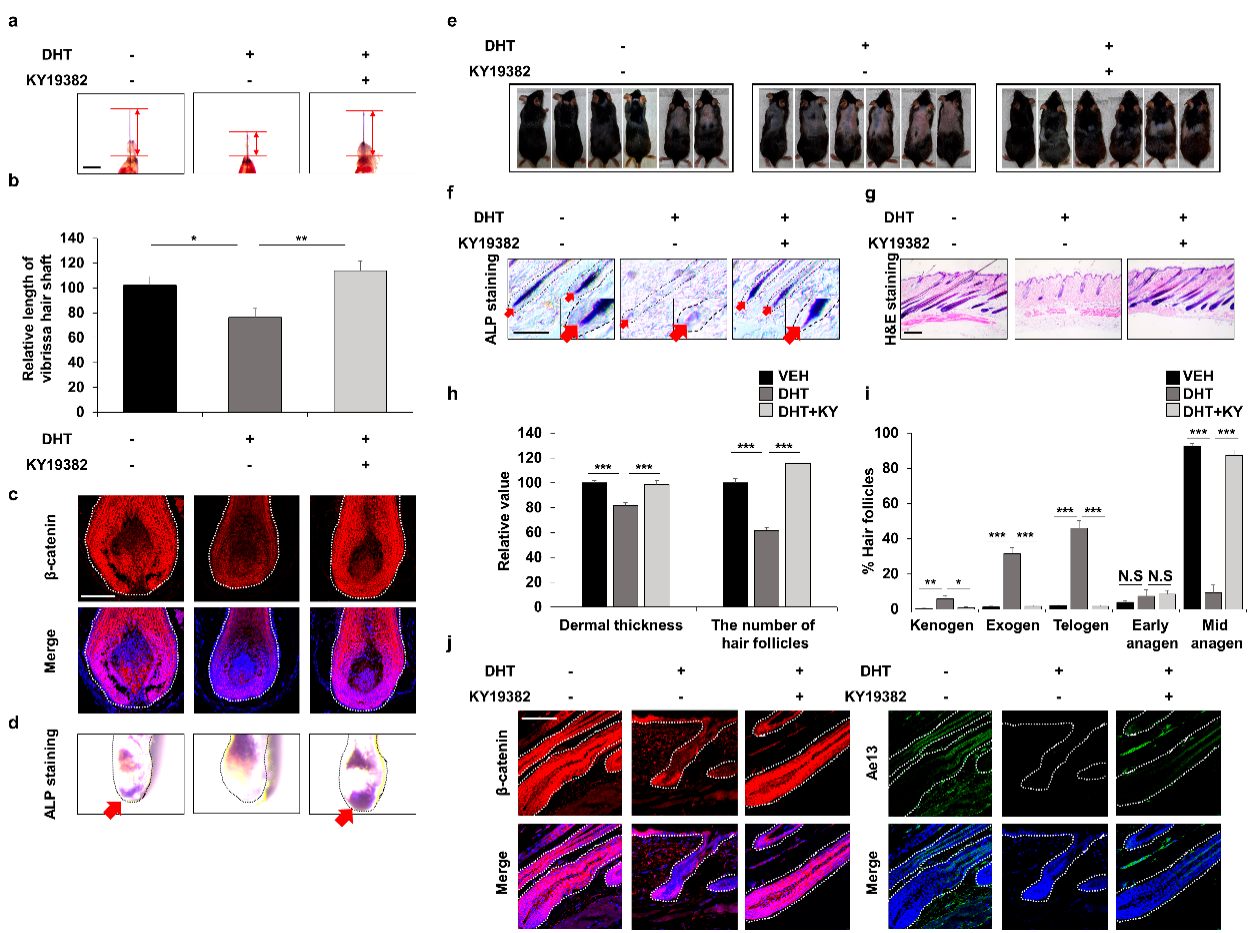
Figure 5. Effects of inhibition of both Cxxc5 and Gsk-3 β functions on hair growth of the DHT-treated mice. ( a – d ) Vibrissa follicles were separated and cultured with 100 nM DHT or 0.5 μ M KY19382 for 4 or 7 days. ( a , b ) The relative length of vibrissa follicles at 7 days ( n = 34). ( c ) IHC staining for β -catenin at 4 days. ( d ) ALP staining for vibrissa follicles. Arrows indicate ALP-positive region. ( e – j ) The dorsal skins of C57BL/6N 8-week-old wild-type mice were shaved and topically treated daily with 100 μ M DHT or 2 mM KY19382. The dorsal skins were harvested at 42 days. ( e ) Gross images of regrown hair in mice ( n = 6). ( f ) ALP staining for dorsal skins. ( g ) H&E staining for mouse dorsal tissues. ( h , i ) Quantitative measurements of dermal thickness, the number of hair follicles, and hair cycle score using H&E images ( n = 30). ( j ) IHC analyses for β -catenin and Ae13 using dorsal skins. Scale bars = 100 μ m. Dashed lines represent hair follicles. Arrows mean ALP-positive region. Values are expressed as the means ± SEM. Student’s t -test: * p < 0.05, ** p < 0.005, *** p < 0.0005, N.S: not significant.